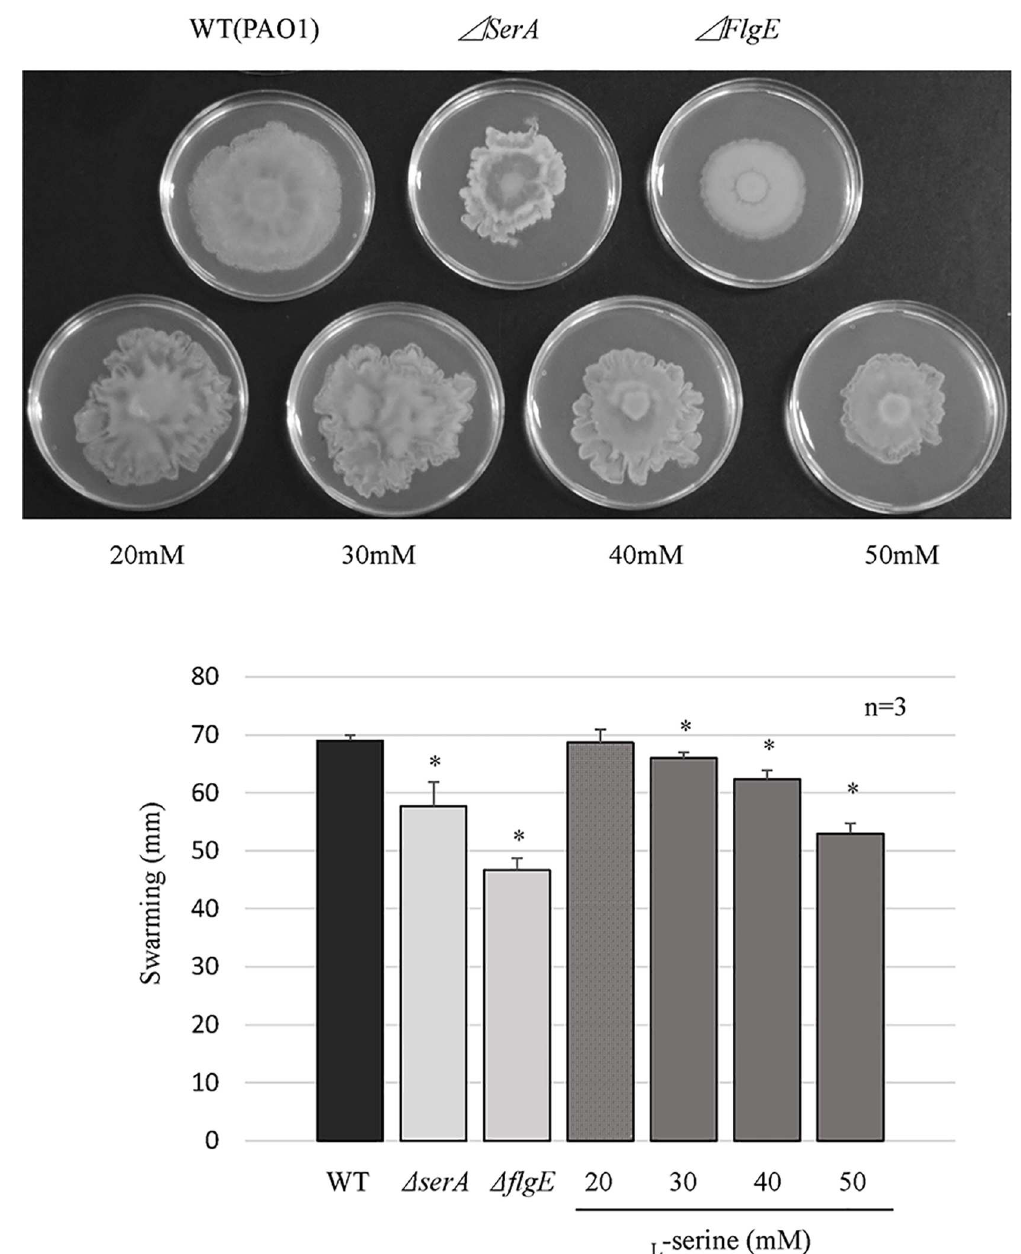
Fig 6. Influence of L -serine addition on swarming motility in the wild-type strain. Swarming motility of the wild- type strain(WT), PAO1Tn:: serA mutant ( Δ serA ),PAO1Tn:: flgE mutant ( Δ flgE )(as a negativecontrol), andWT in the presenceof L -serine(20, 30, 40, and50 mM). A representative imageof the swarmingmotility assayis shown.The majoraxis of swarmingis the longestlengthof the swarmingarea. The assay was performed in triplicate, andthe resultsare expressed as the mean ± SD. Significant differences wereobservedbetweenWT and Δ serA ( * :P < 0.05), betweenWT and Δ flgE ( * :P < 0.05),betweenWT andWT in the presenceof 30 mM L -serine( * :P < 0.05),between WT andWT in the presenceof 40 mM L -serine( * :P < 0.05), andbetween WT andWT in the presenceof 50 mM L - serine( * :P <